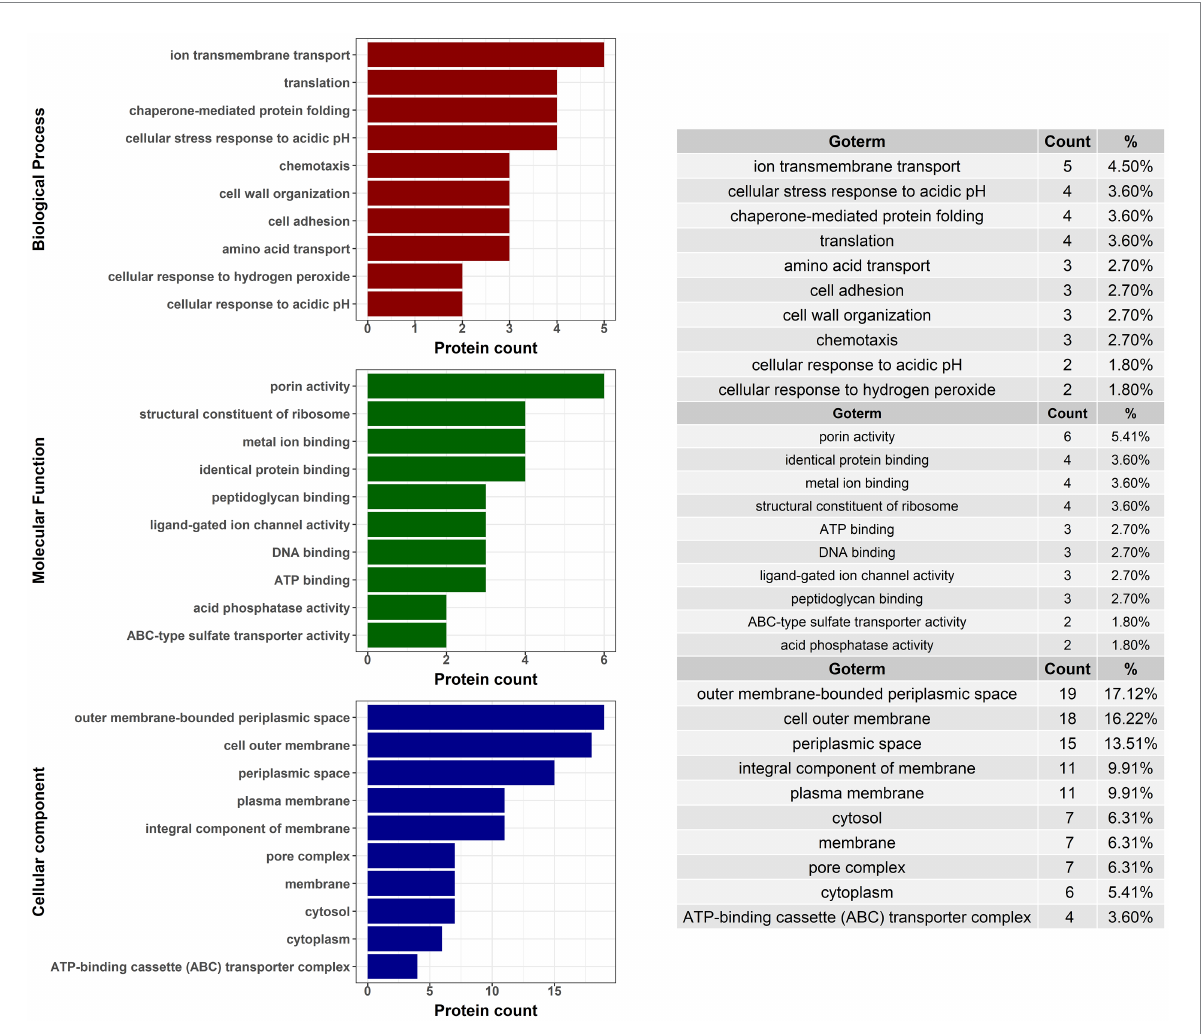
FIGURE 6 Gene ontology (GO) analysis of proteins with at least a two-fold change in expression for STEC strains that exhibited MFGMP adhesion capabilities, O26:H11 str. 21765 and O103:H2 str.